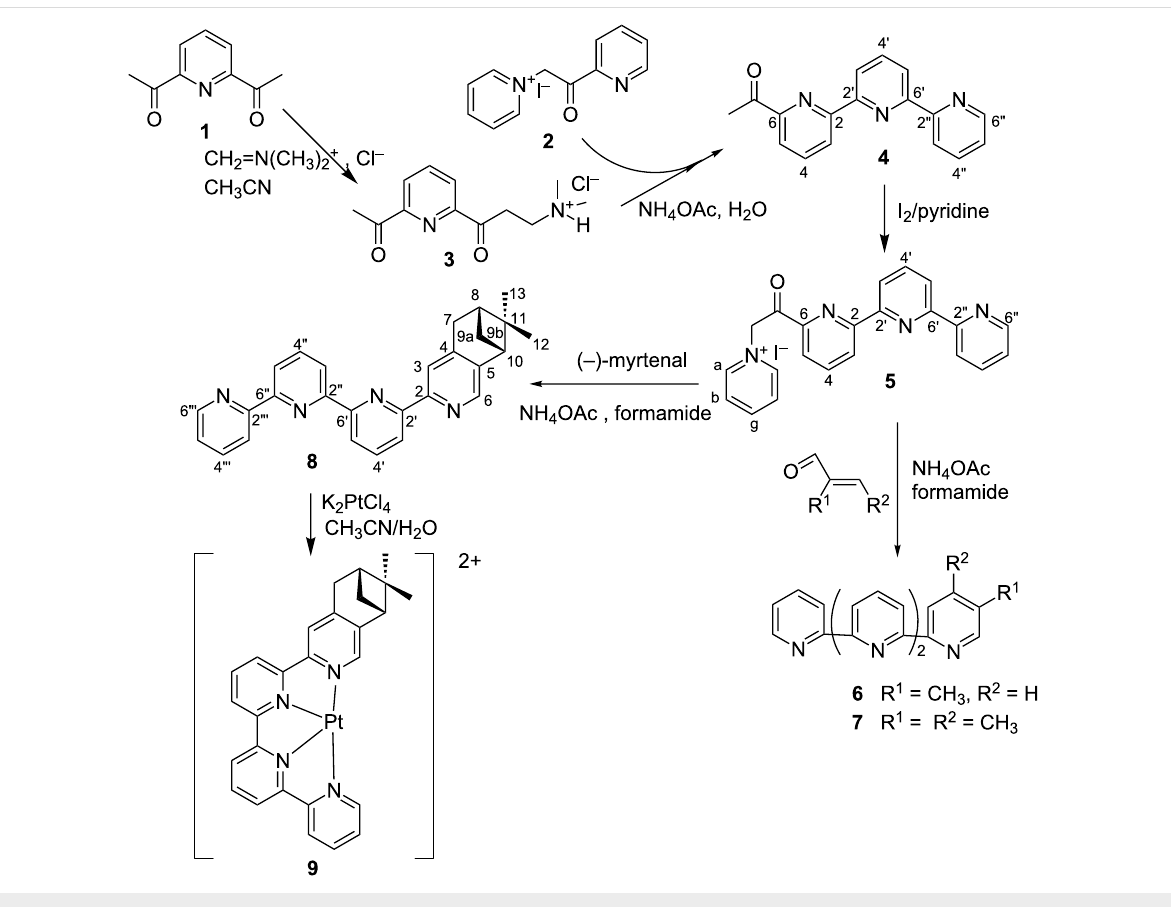
Scheme 1: Synthesis of the quaterpyridines 6–8 and of the platinum complex 9